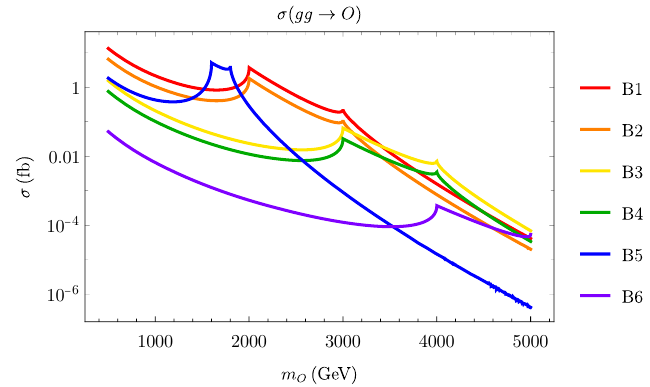
Figure 9. Cross sections in benchmarks B1{B6 of single scalar sgluon production due to gluon fu-